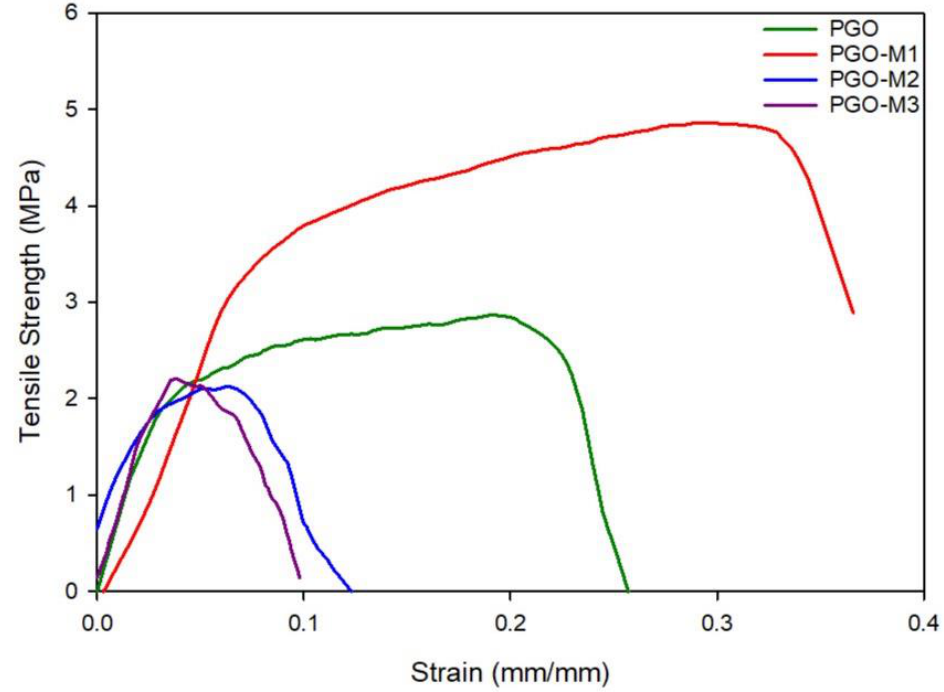
Figure 8. Stress–strain curve of the functionalized Figure 8. Stress – strain curve of the functionalized nanofibers. Table 2. Tensile properties of the functionalized PGO nanofibers.